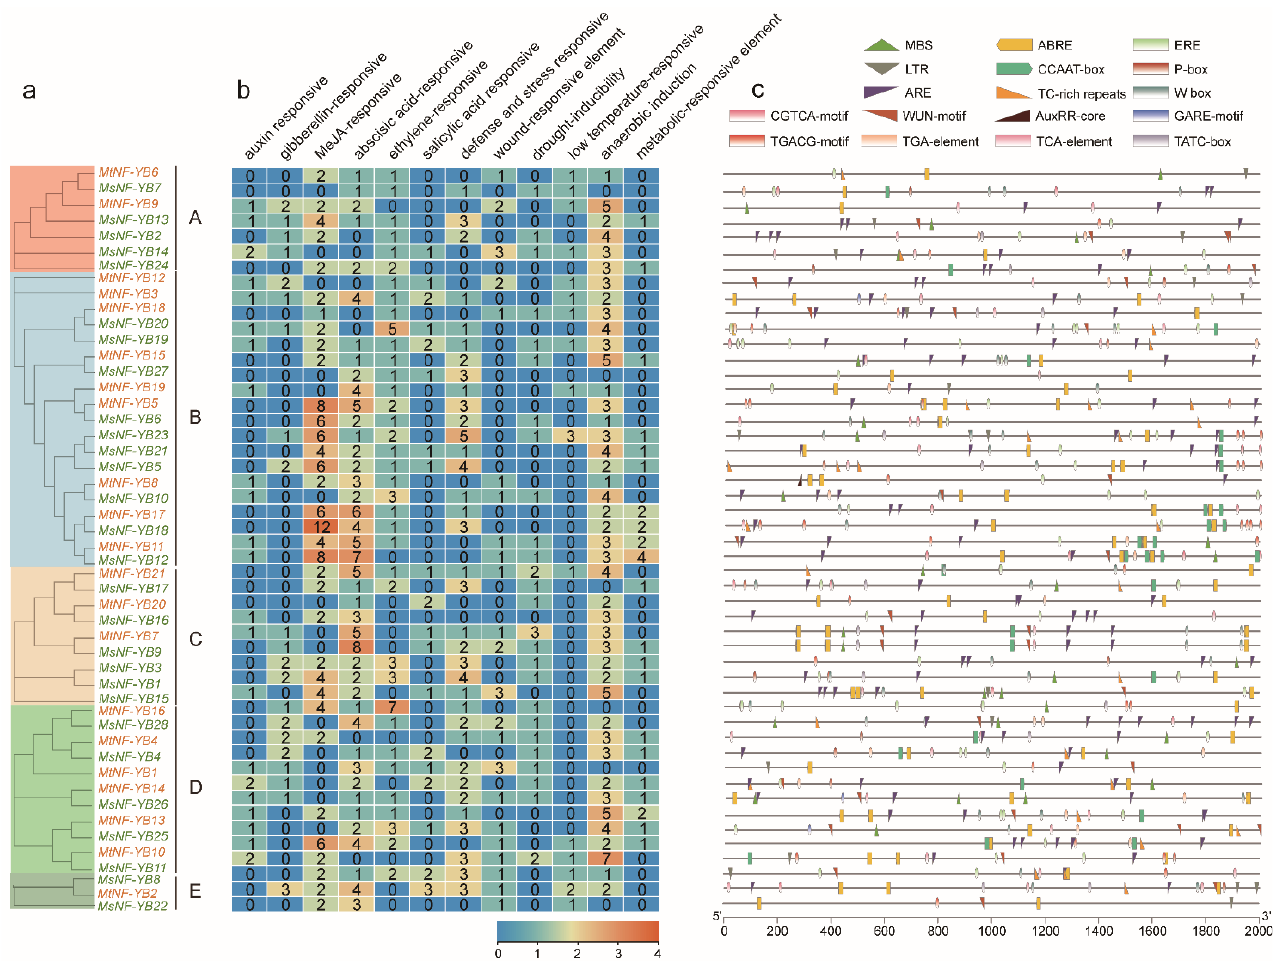
Figure 5. Putative cis -elements and transcription factor binding sites in the promoter regions of NF-YB genes from M. truncatula and M. sativa . ( a ) The groups and color are as indicated in Figure 2. ( b ) The color and number of the grid indicate numbers of different cis -acting elements in these NF-YB genes. ( c ) The colored blocks represent different types of cis -acting elements and their locations in each NF-YB gene.